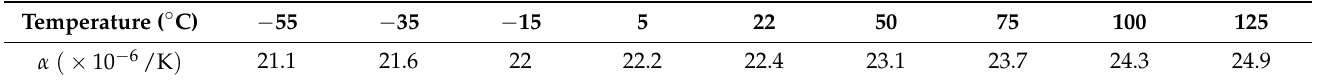
Table 4. Coefficient of thermal expansion of SAC305 (temperature dependent).